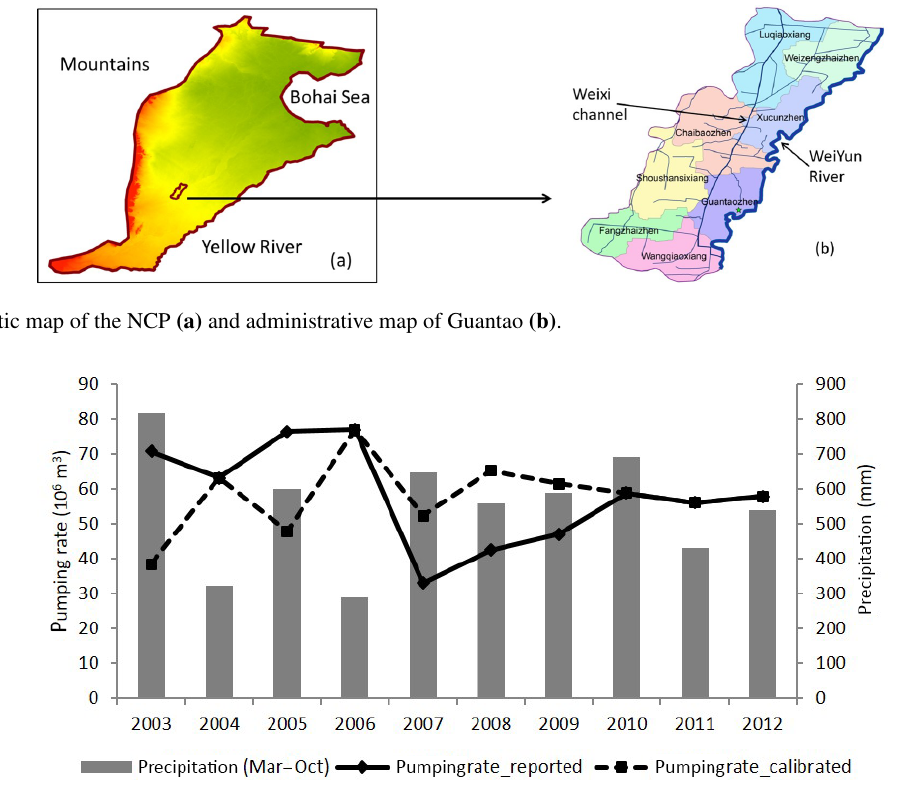
Figure 2. Time series of the annual pumping rates in the shallow aquifer shown together with annual precipitation (solid line: reported data; dashed line: values adjusted during